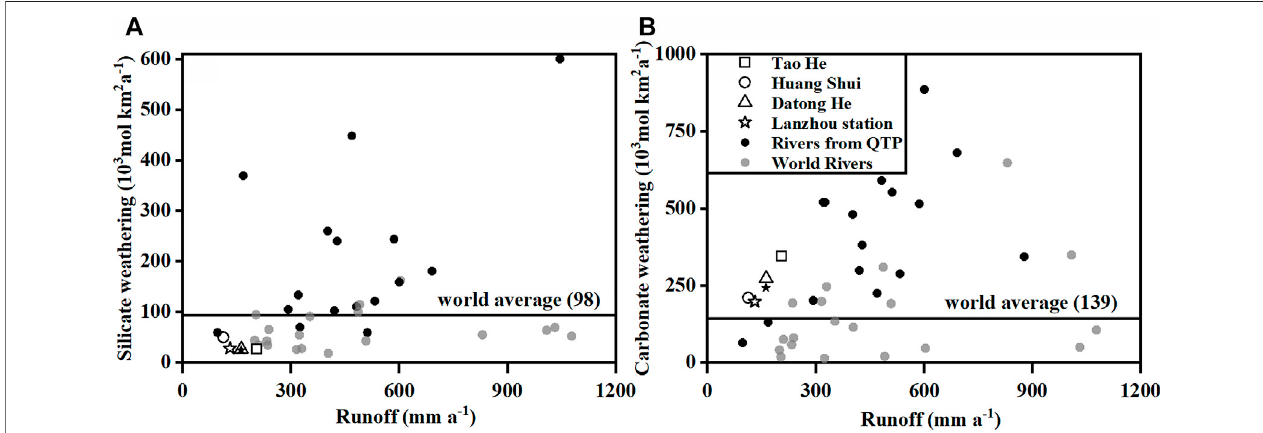
FIGURE 8 | Comparison of the CO 2 consumption rates by chemical weathering for the rivers originating on the QTP and in other basins. The un fi lled symbols are thedatainthispaper.TheblacksolidsymbolsrepresentdatafortheQTPrivers,whicharefromGaillardetetal.(1999),Singhetal.(2005),Wuetal.(2008a,b),Nohetal. (2009), Wang et al. (2016), and Zhang et al. (2019). The gray solid symbols represent rivers in other basins with discharges exceeding 200 km 3 a − 1 (data from Gaillardet et al., 1999). The average value of CO 2 consumption rate of silicate and carbonate weathering for the world ’ s rivers is from Gaillardet et al. (1999).